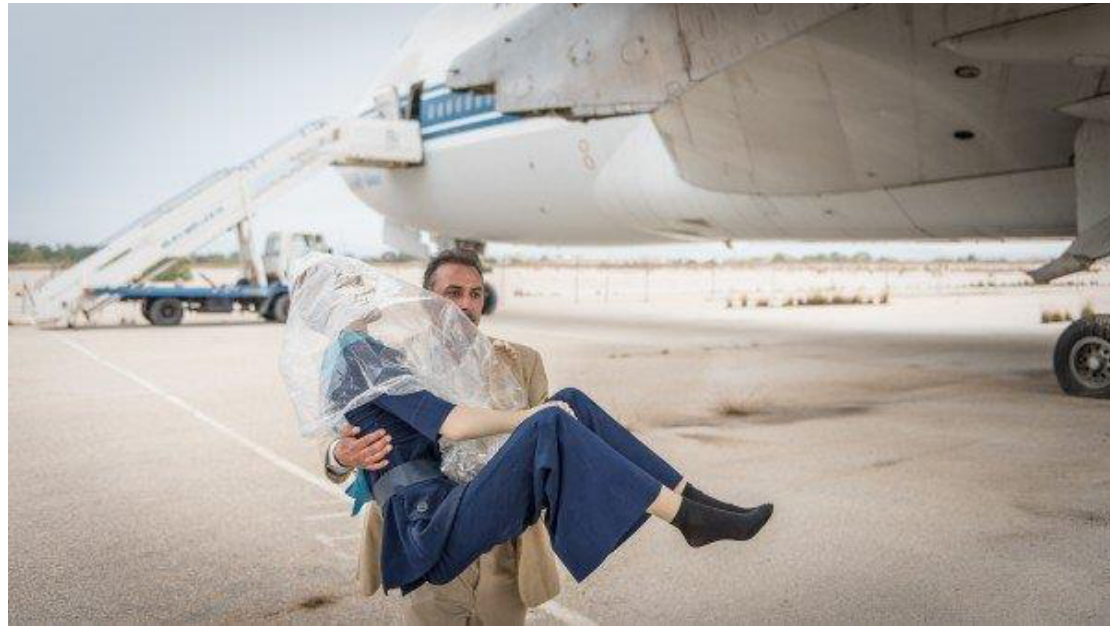
Figure 3. Naeem Mohaiemen, still from Tripoli Cancelled , 2017, digital video (color, sound), 95 min. © 2017 Naeem Mohaiemen. Courtesy of the artist and Experimenter, Kolkata.